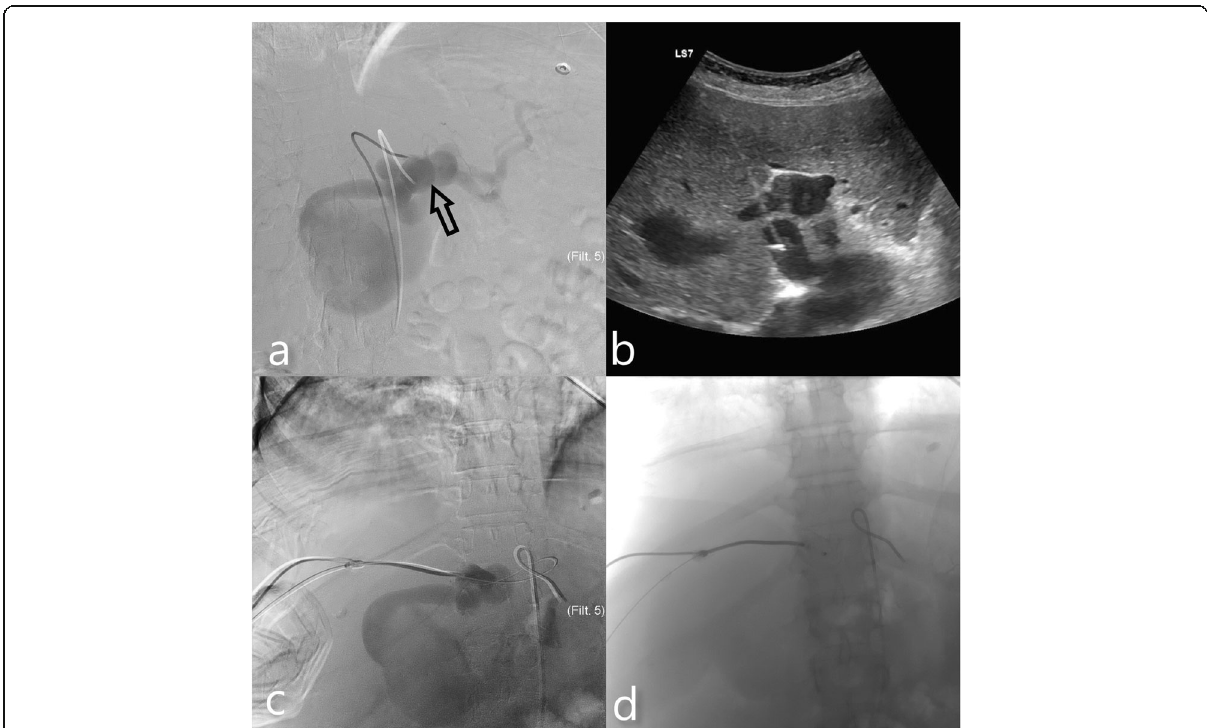
Fig. 2 Celiac artery angiogram ( a ) showing the APF location (hollow black arrow). The aneurysm also fills at early phase of the contrast media injection US image ( b ) showing the needle localization during percutaneous transhepatic puncture of left hepatic artery. c Contrast injection through hepatic access shows exact localization of the vascular sheath ( d ) Amplatzer vascular plug II